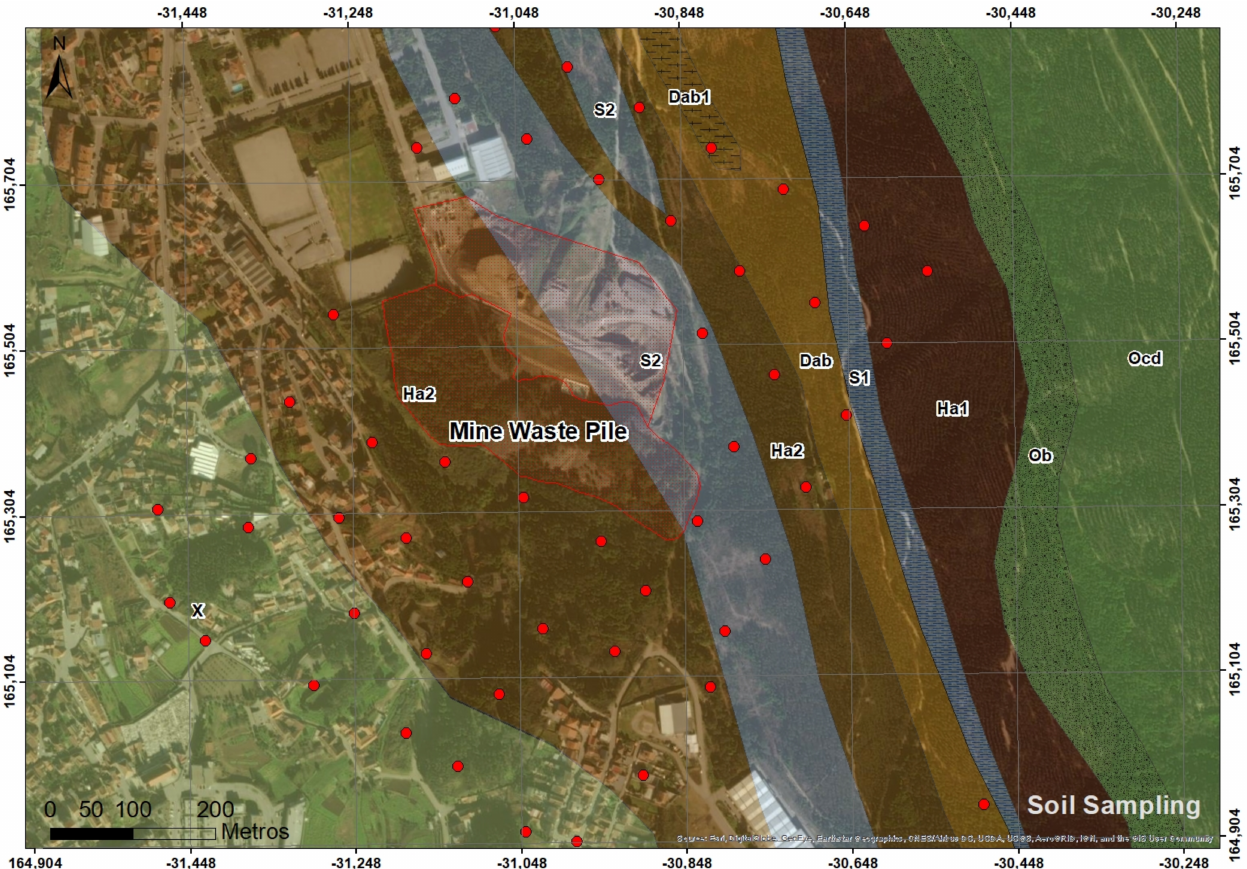
Figure 5. Settings of the sampling grid. Legend: X1—Precambrian and/or Cambrian schists and greywackes; Ob— Ordovician quartzites with schists intercalations; Ocd—Ordovician shales; S1—Silurian schists with Monograptus; S2— Silurian schists, greywackes and quartzites; Dab—Devonian shales and sandstones; Dab1—Devonian quartzites; Ha1— Carboniferous conglomerates, sandstones and micaceous schists; Ha2—Carboniferous conglomerates, arkoses, carbonaceous schists and